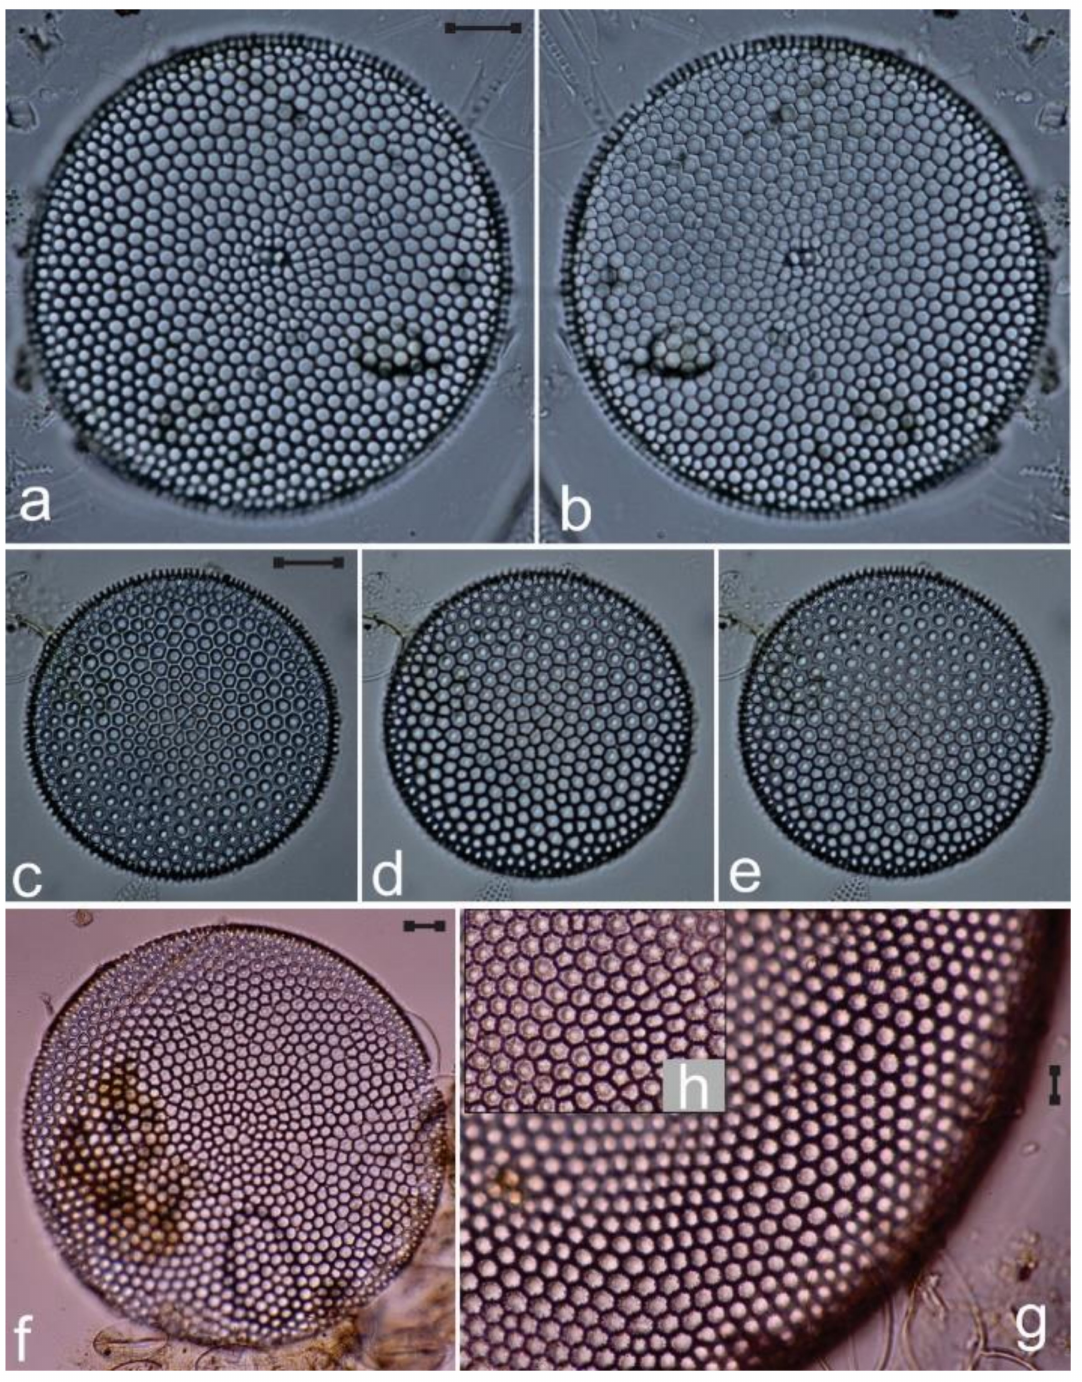
Figure 5. ( a – f ) Coscinodiscus radiatus valves in di ff erent focal views; ( g , h ) C. gigas , image h section of the valve (center) showing the arrangement of the areolae. Scale bar = 10 µ